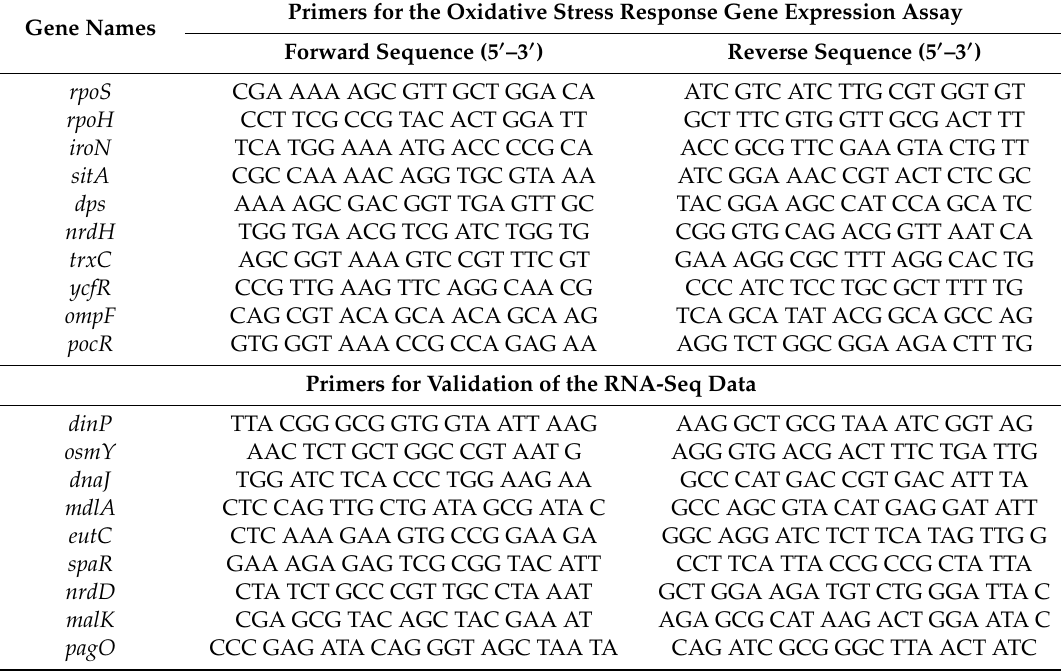
Table 1. Primers used in this study for the oxidative stress response gene expression assay and validation of RNA-seq